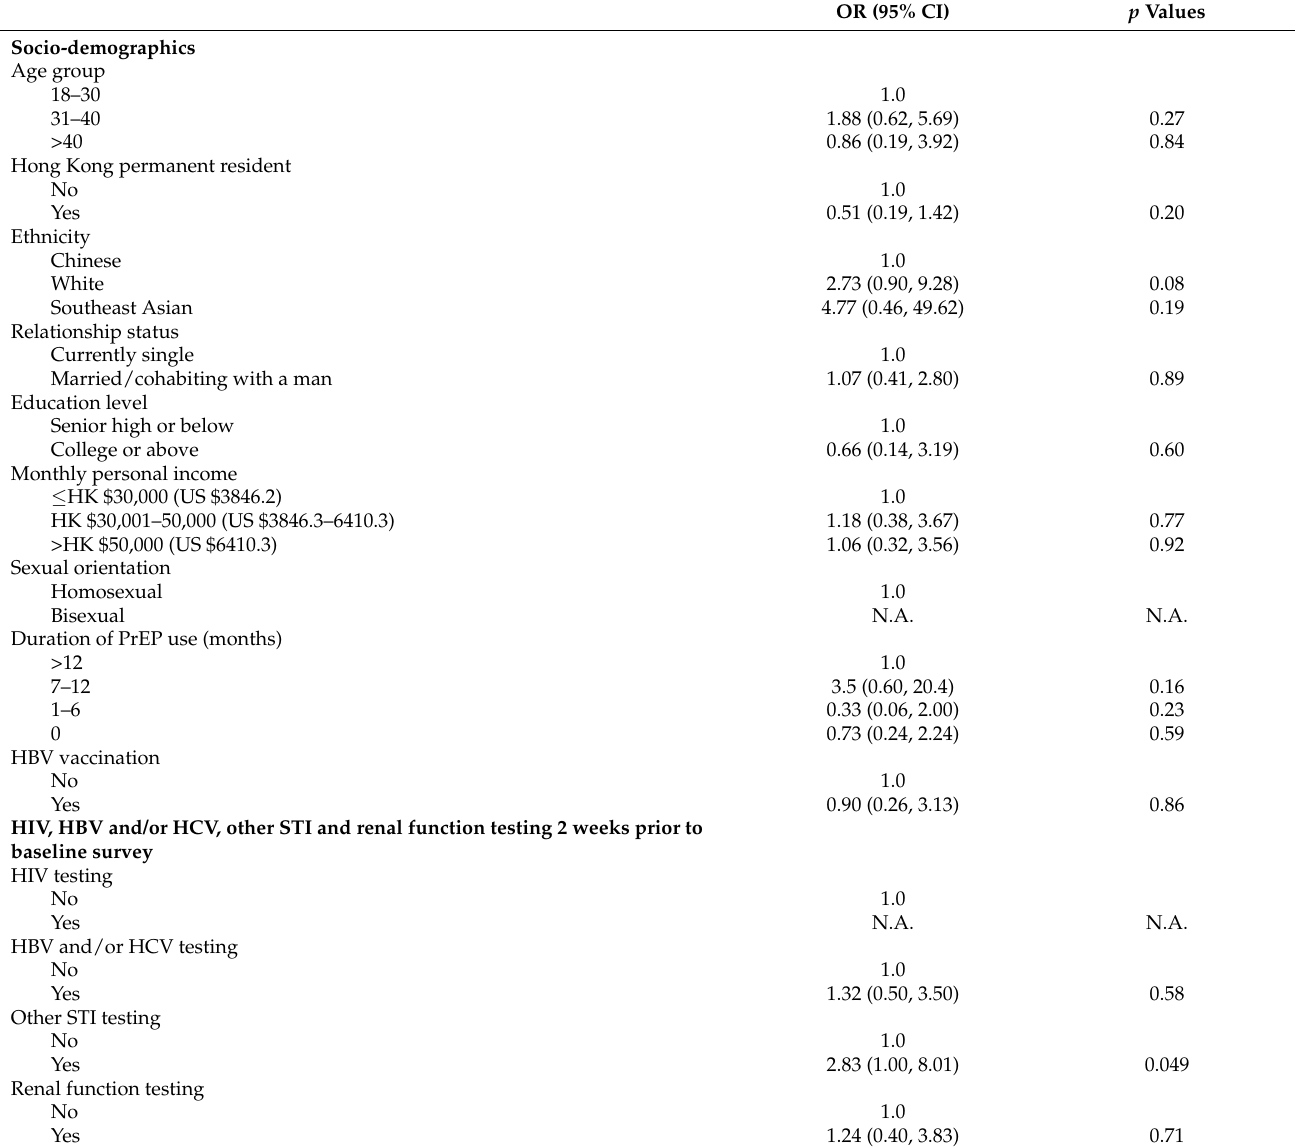
Table 3. Associations of background characteristics and STI testing uptake during the follow-up period (among participants being followed up at Month 3, n =